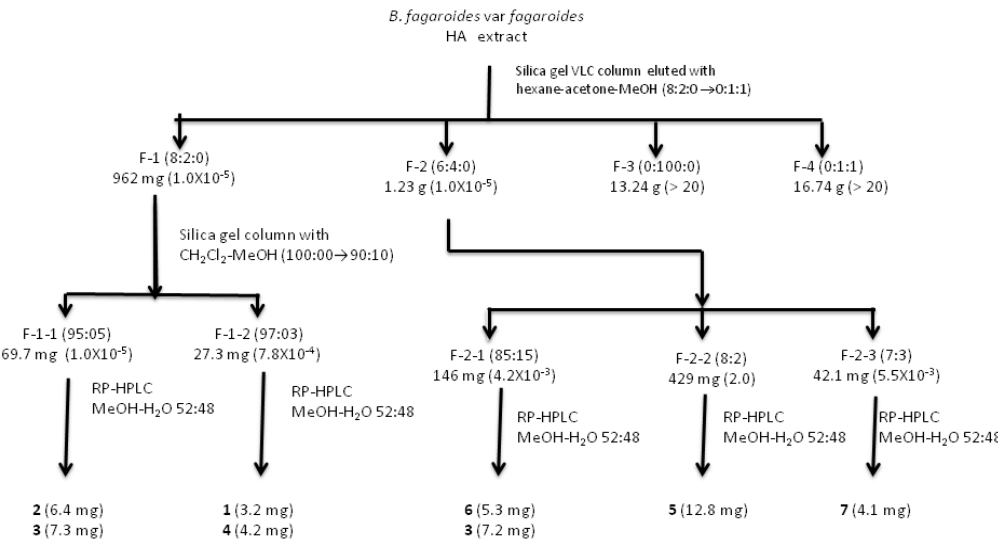
Figure 2. Fractionation tree diagram of the HA extract, monitored by the cytotoxic activity values in μ g/mL in square against PC-3 cell line in culture (ED 50